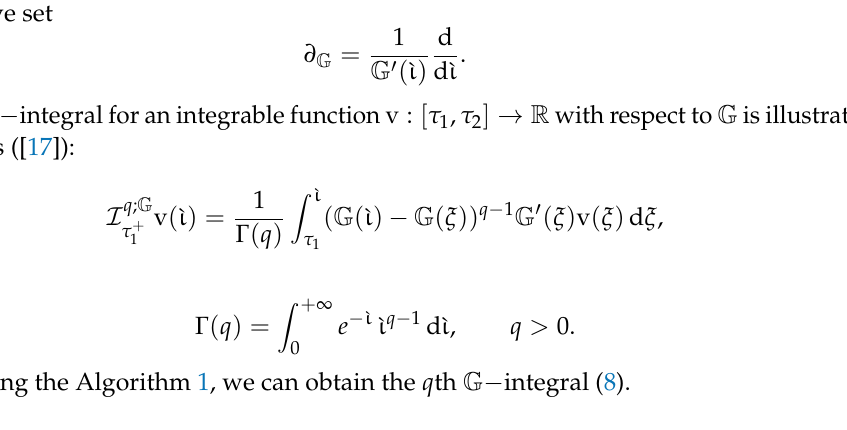
Algorithm 1: MATLAB lines for getting the q th G − integral of function